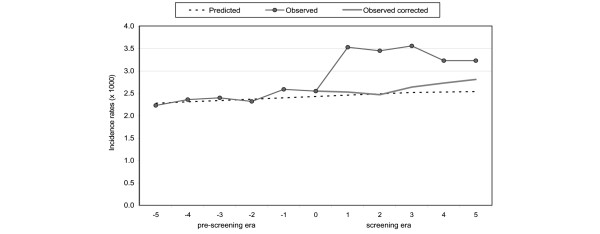
Breast cancer incidence rates predicted, observed, and observed corrected for lead time. The participants were aged 50 to 74 years.